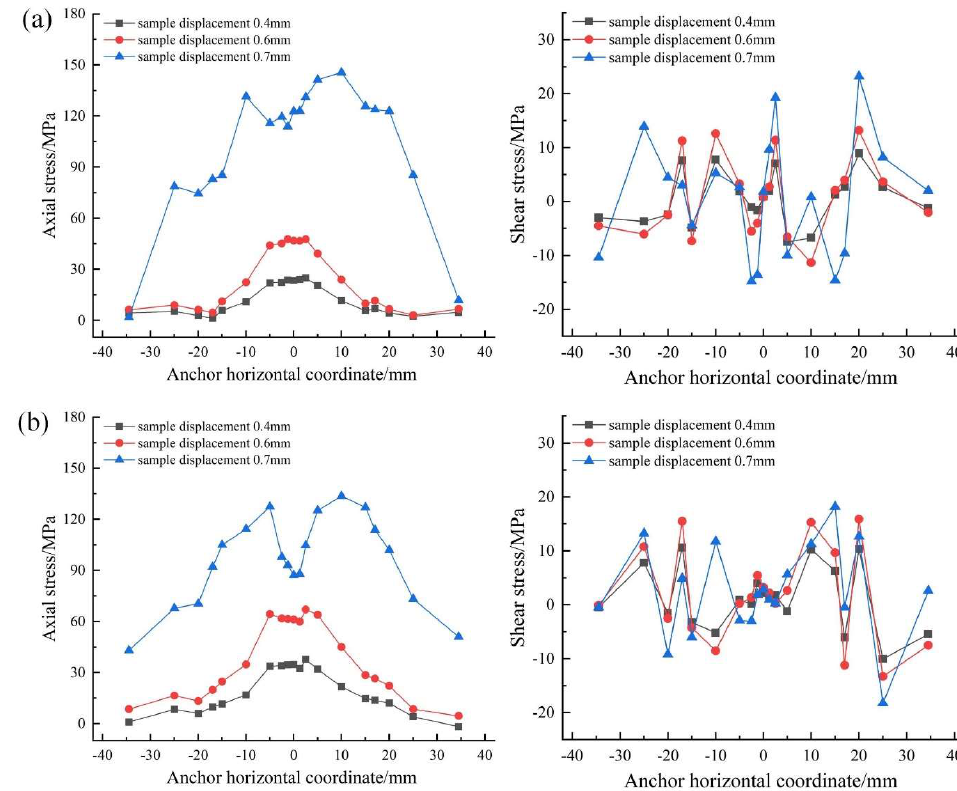
Figure 23. Axial and shear stress distribution for anchor: ( a ) F−90 sample; ( b ) R−90 sample.